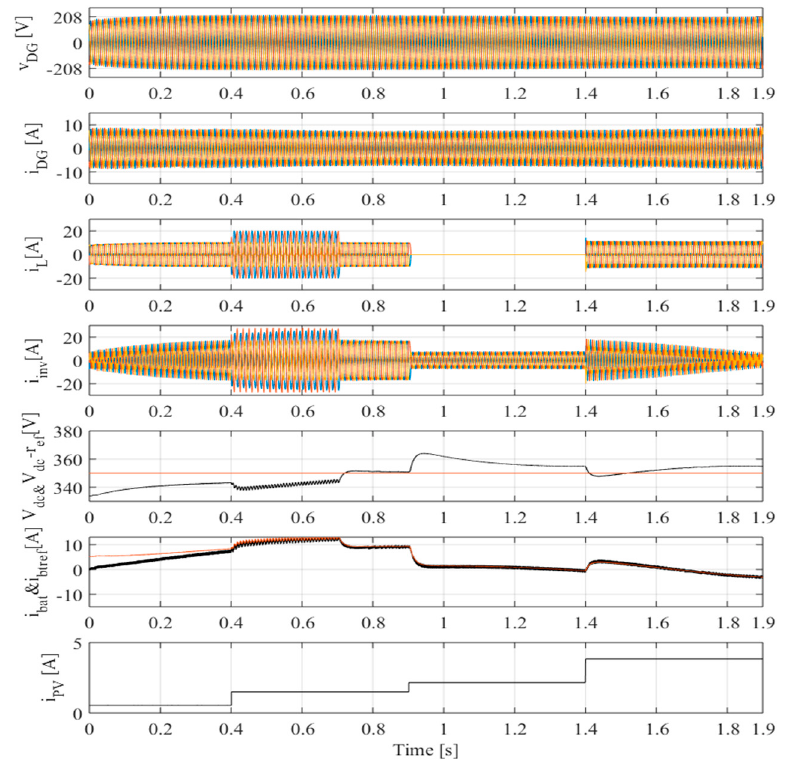
Figure 9. Dynamic performance under presence of balanced and unbalanced nonlinear load (diode bridge +RL and RC loads) and solar irradiation change.